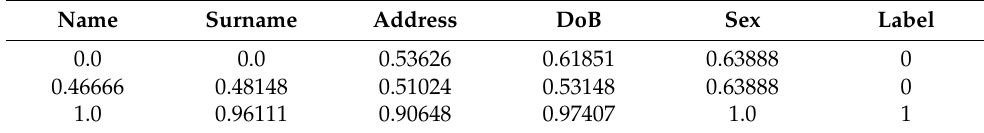
Table 1. Training dataset